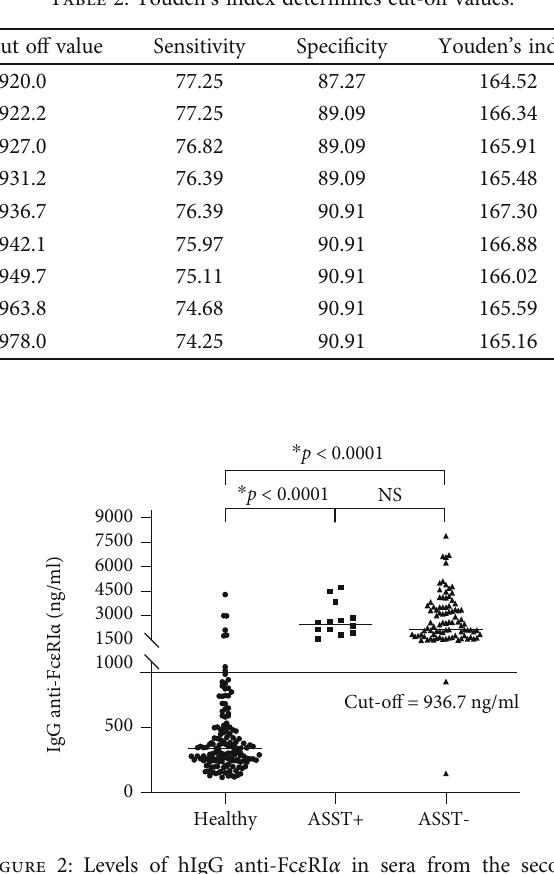
Figure 1: Overlay of levels of hIgG anti-Fc ε RI α in sera from healthy and CSU donors. (a, b) Bar graphs overlayed with scatter plots represent levels of human IgG against anti-Fc ε R1 α in healthy groups, ASST positive, and ASST negative ( mean ± SEM ). ∗ A p value of less than 0.05 was statistically signi fi cant. Table 2: Youden ’ s index determines cut-o ff values.